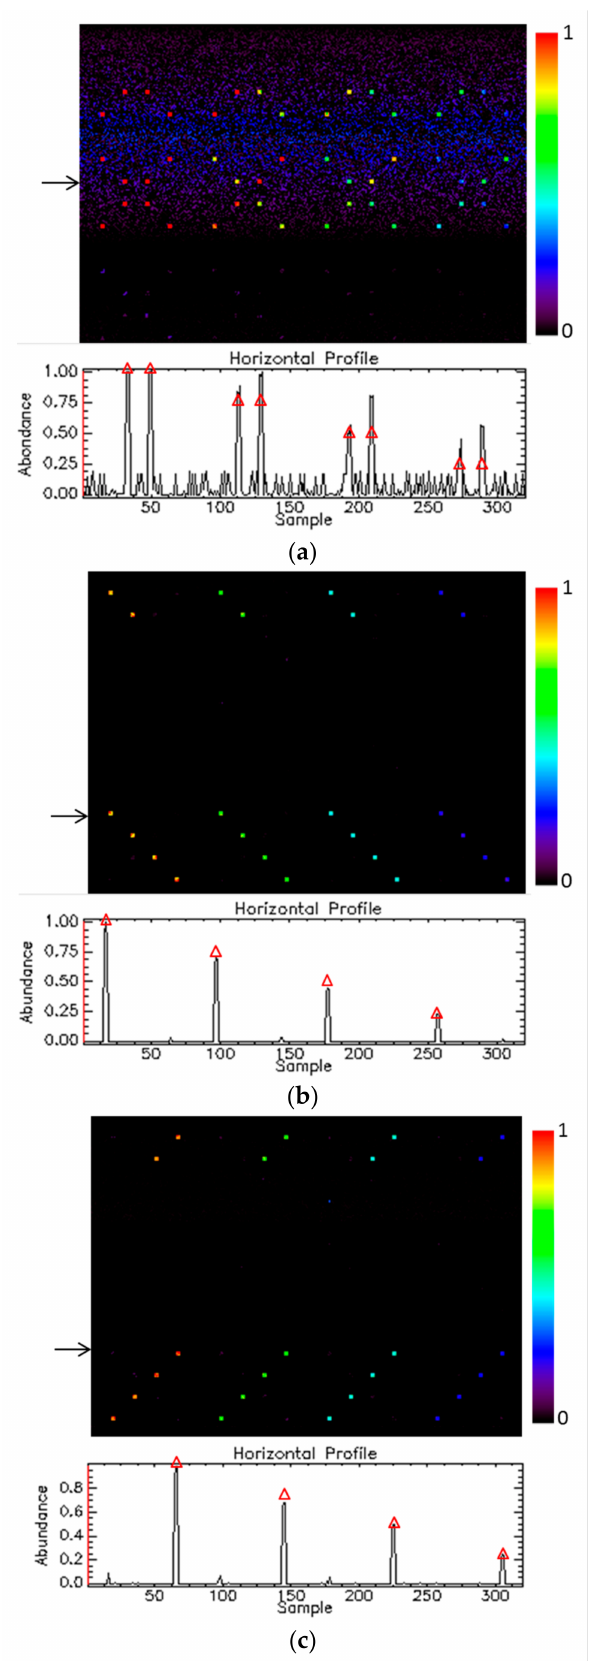
Figure 8. Abundance map (OSPv1) of HC+soil ( a ), crude oil+sand ( b ) and gasoil+sand ( c ). A horizontal (marked by the arrow) profile of the abundance is drawn. Red triangles indicate the true